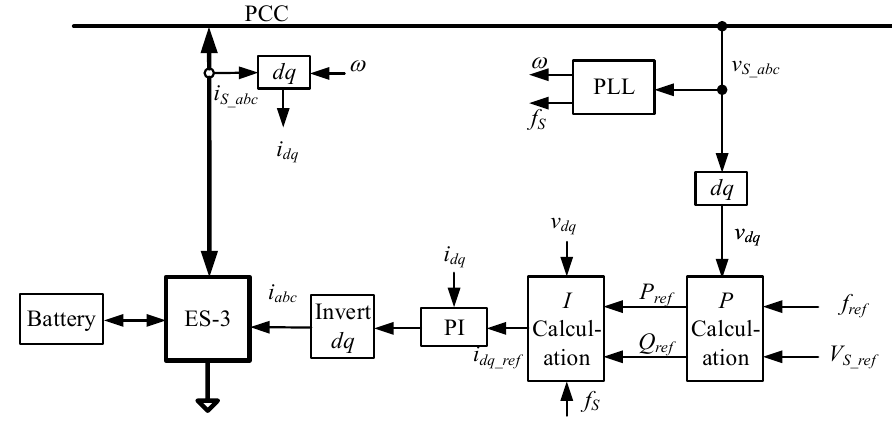
Figure 6. Power decoupling control scheme of ES-3 [25].